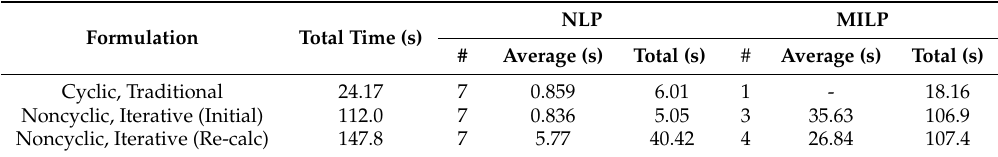
Table 23. Computational results: Scenario